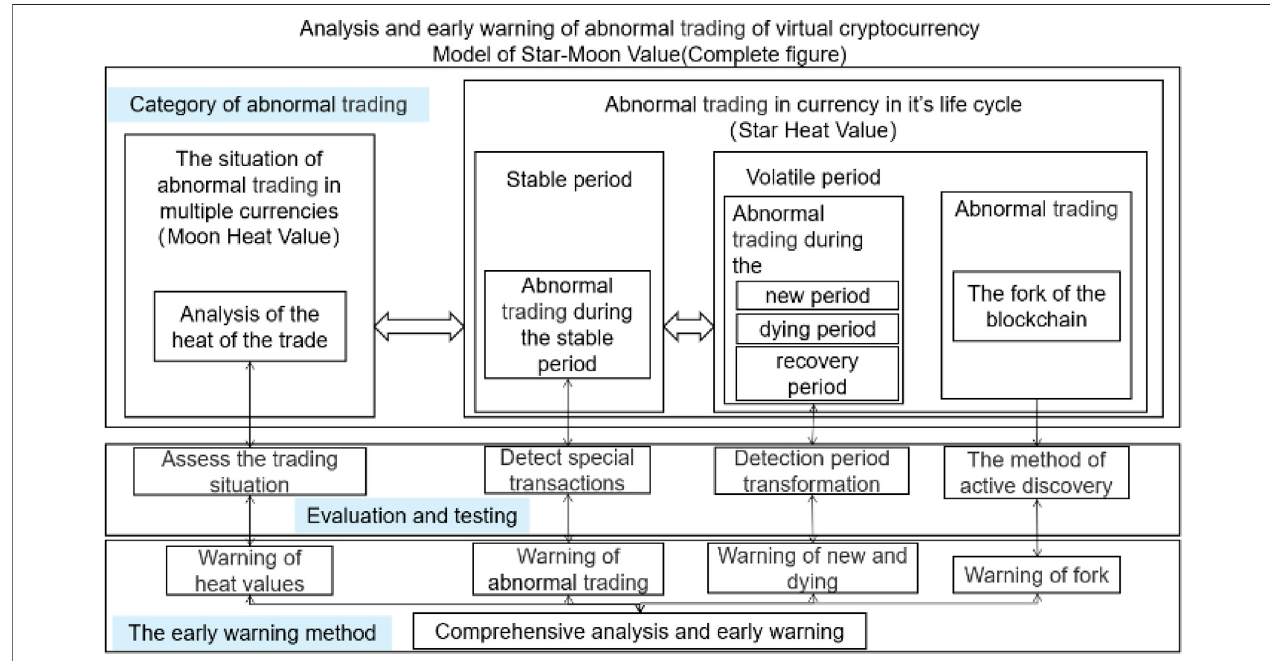
FIGURE 2 | Stellaluna value model for anomaly analysis and warning of virtual